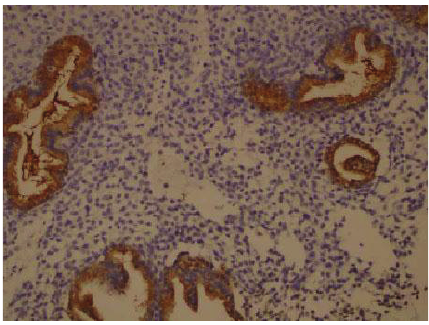
Figure 3: Strong glycodelin expression ( ×